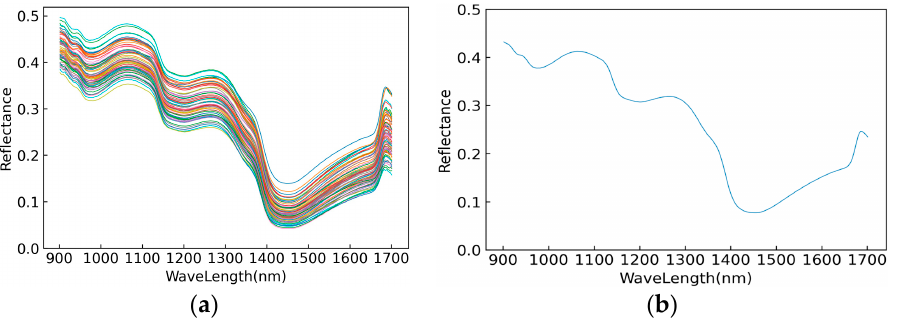
Figure 3. Original spectral reflectance map ( a ) and average spectral reflectance map ( b ) of all tested ‘Huangguan’ pears.